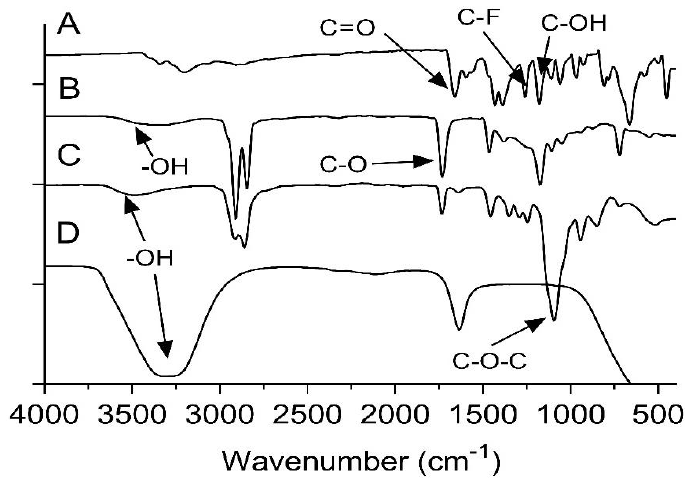
Figure 4. FTIR spectra of ( A ) unprocessed FPV, ( B ) Compritol 888, ( C ) Tween 80, and ( D ) FPV- SLNs.